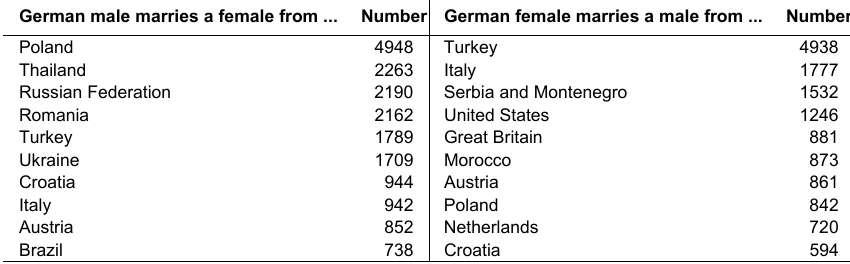
Source: Statistisches Bundesamt